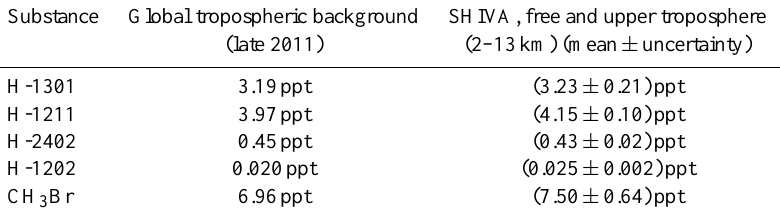
Table 9. Overview of long-lived brominated substances. The global tropospheric mean for H-1301, H-1211, H-2402 and CH 3 Br are an update of Montzka et al. (2003), H-1202 is taken from Newland et al. (2013). The measurement uncertainty is the sum of scale accuracy and instrumental measurement precision. The atmospheric variability is not contained in the